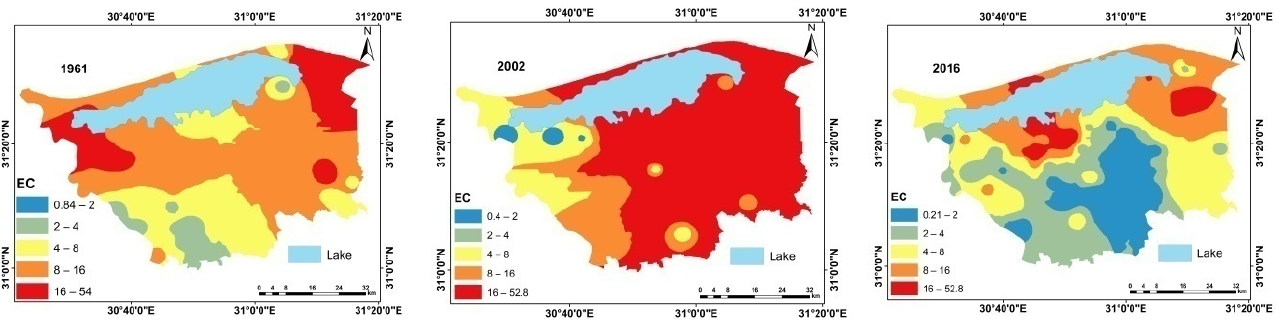
Figure 8. Soil EC maps in 1961, 2002, and 2016.